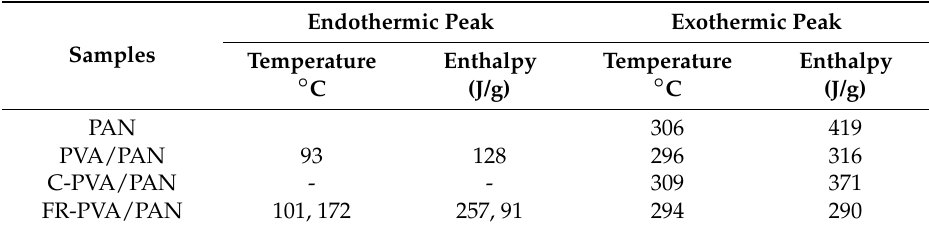
Figure 4. DSC curves of PAN, PVA/PAN, C-PVA/PAN, and FR-PVA/PAN fibers. Table 3. Thermal properties of different fibers resulting from DSC.